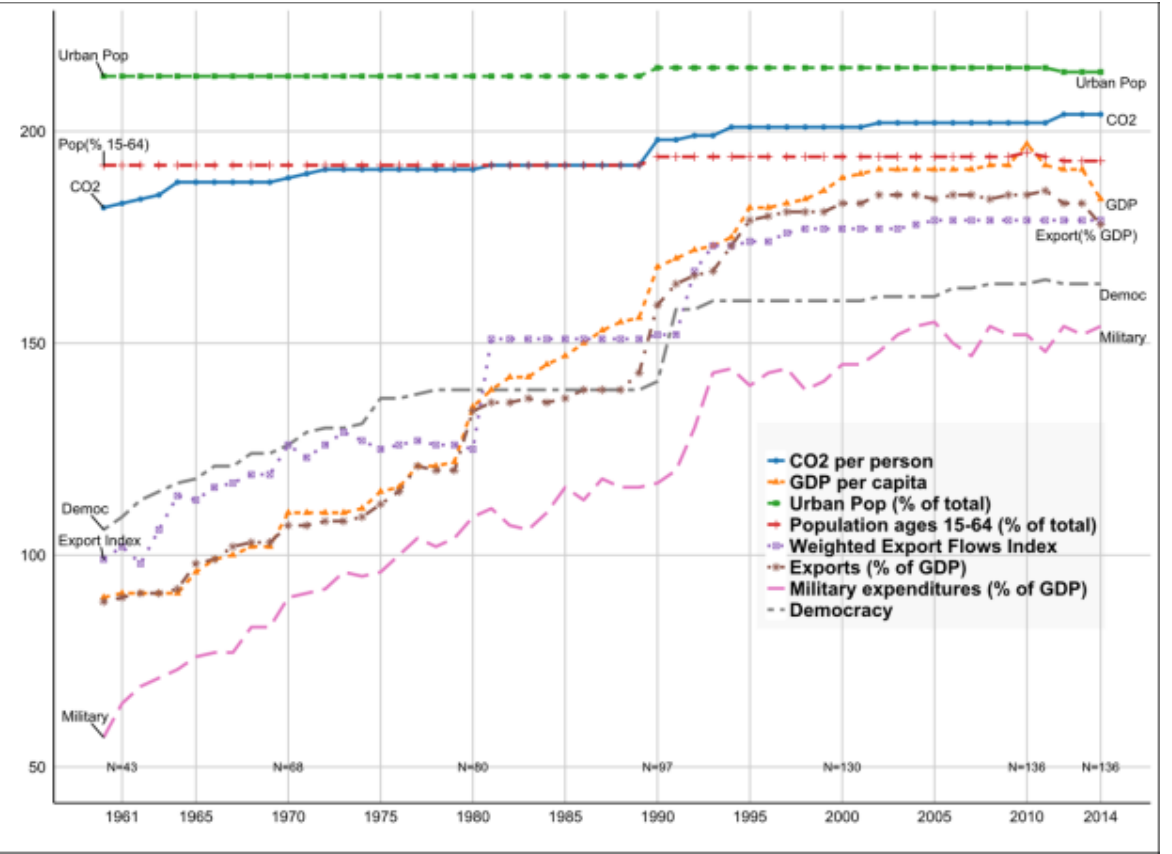
Figure 1. Annual Observations per Variable